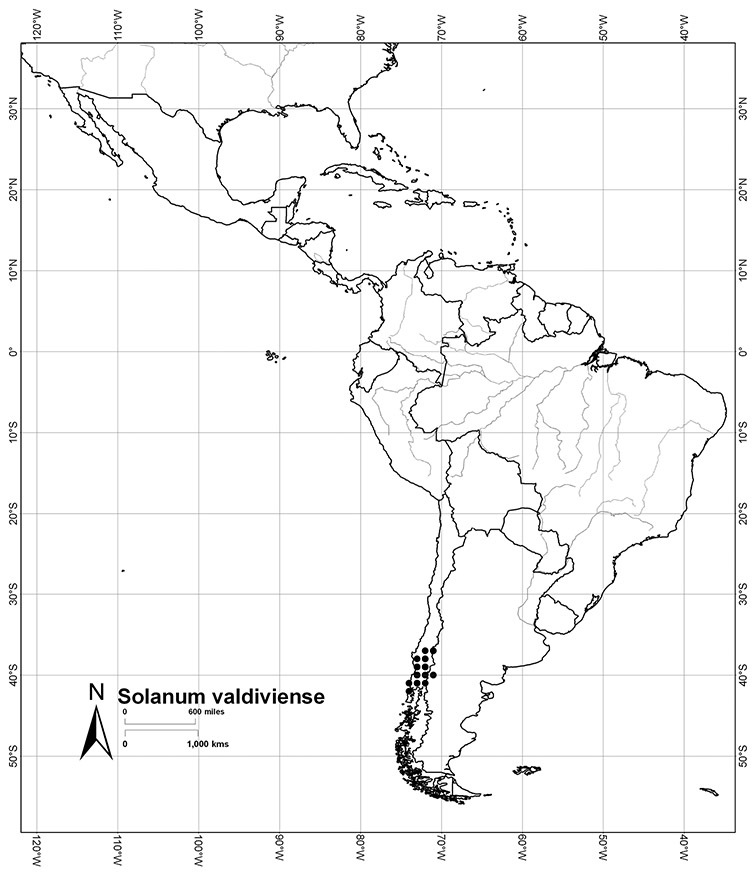
Distribution of Solanum valdiviense Dunal.